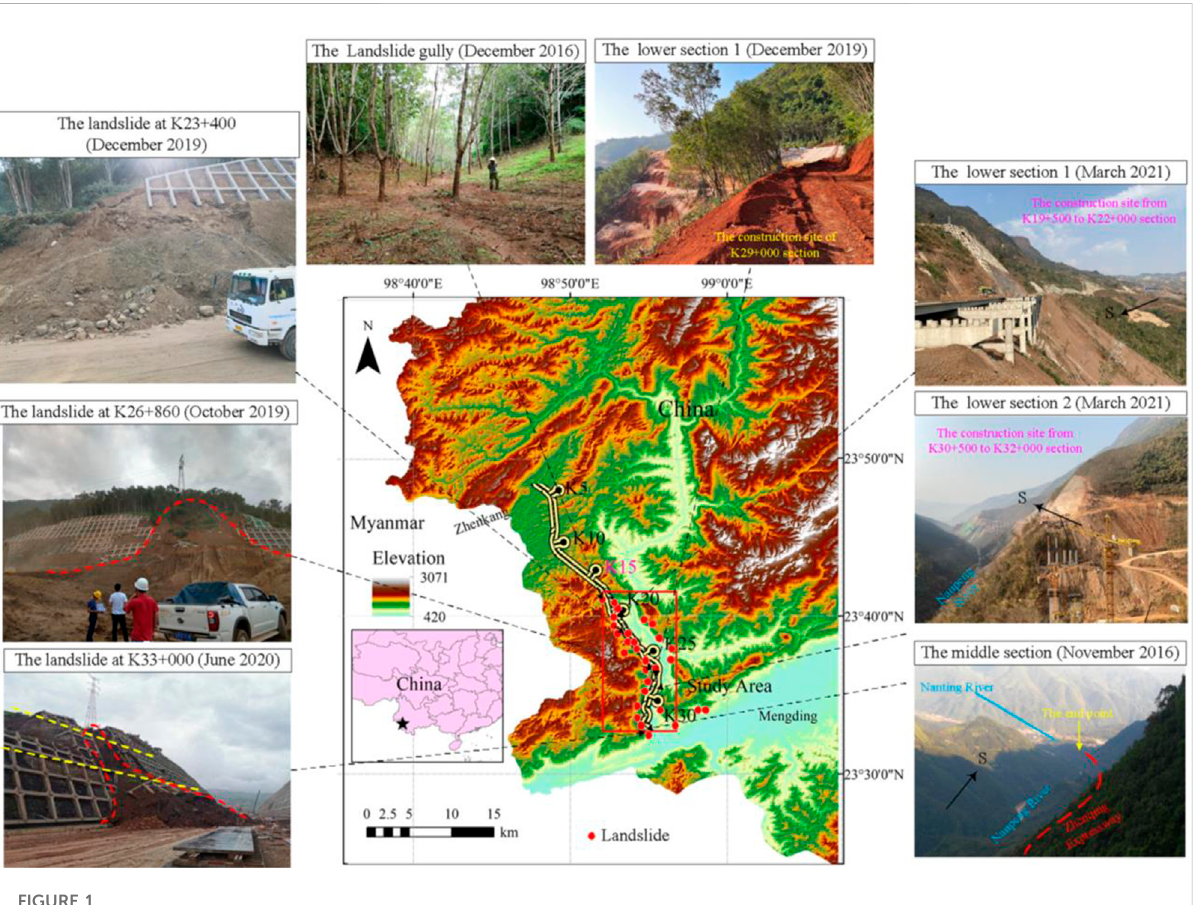
Location and typical landslides of the research